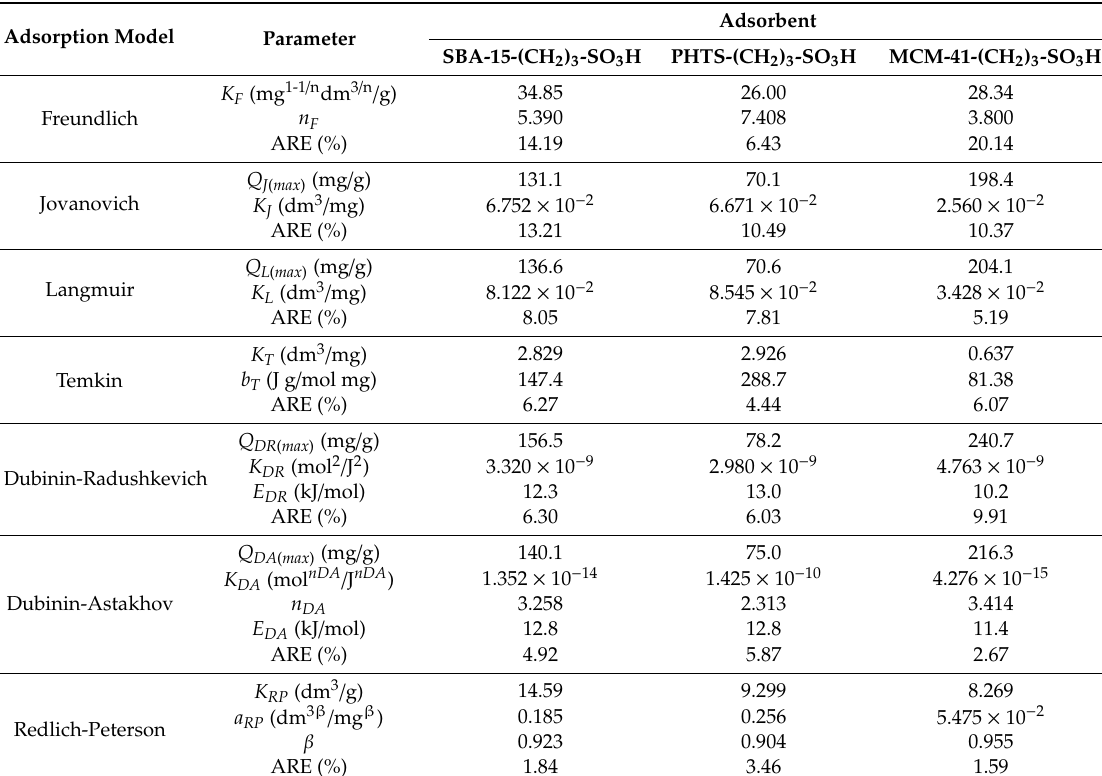
Table 3. Isotherm parameters calculated from a nonlinear fitting analysis of ticagrelor adsorption onto propyl-sulfonic acid modified mesoporous